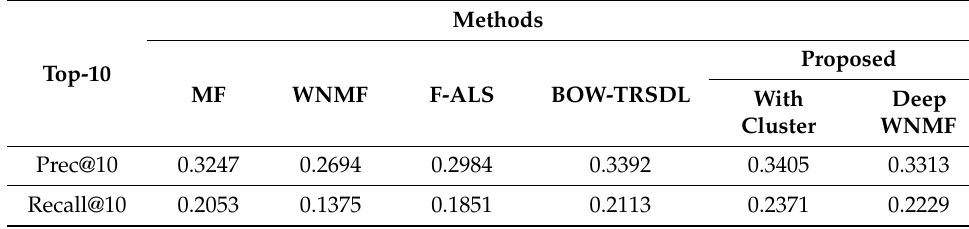
Table 4. Top-10 performance